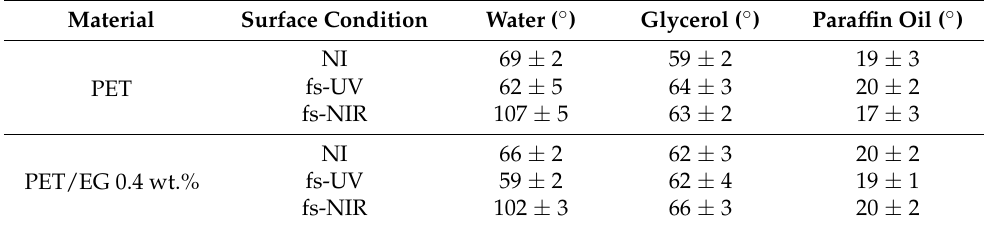
Table 2. Contact angles of the different probe liquids (water, glycerol, and paraffin-oil) of non- irradiated (NI) and irradiated (fs UV and fs NIR pulses) on PET and PET/EG 0.4 wt.% surfaces, obtained by the sessile drop technique. The data listed correspond to the average and standard deviation of three different